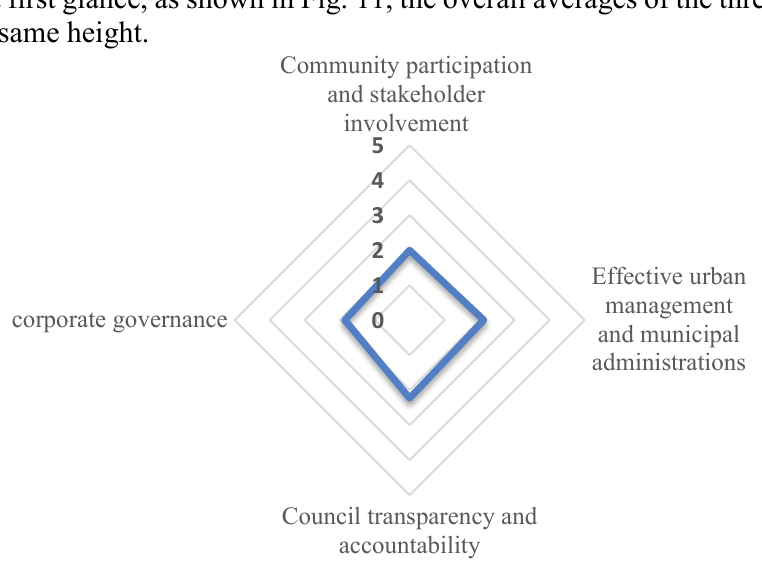
Fig. 11. Measuring the performance of the urban projects (created by the